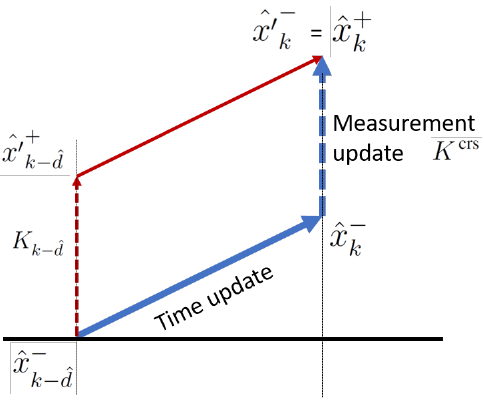
Figure A1. Optimality of the latency compensated